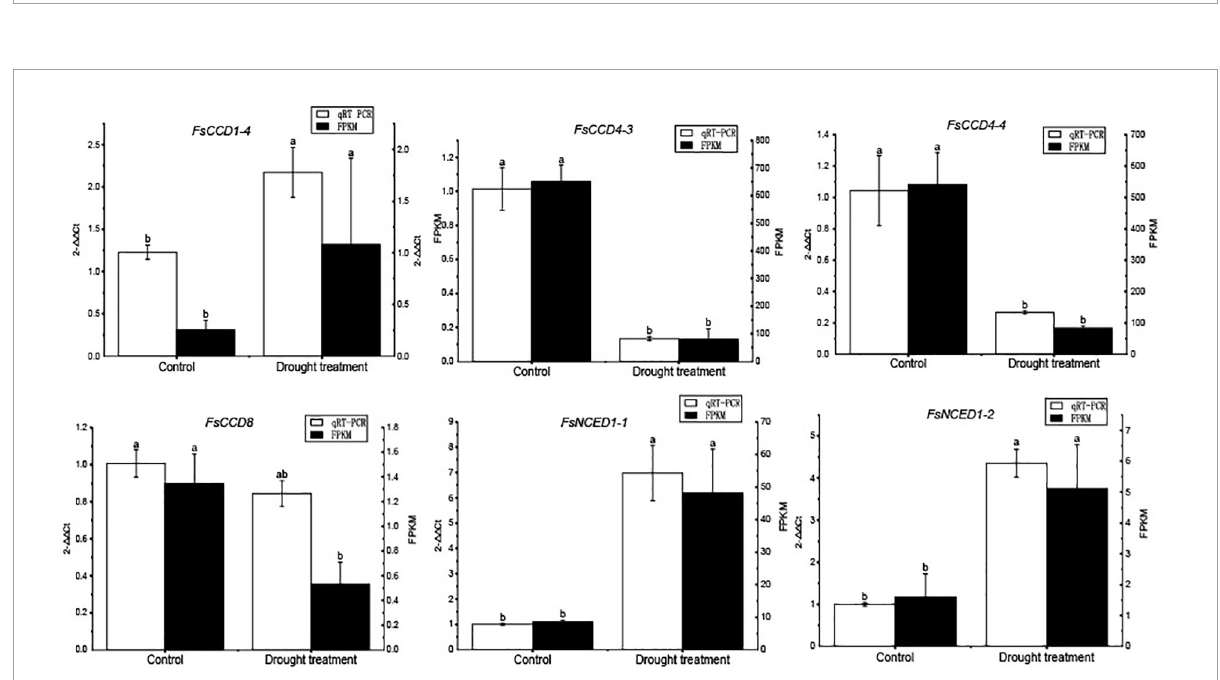
FIGURE10 qRT-PCR verification of the CCD genes of Forsythia suspensa under drought stress. Comparison of q RT-PCR (white bar) with RNA-seq data (black bar). The relative changes were calculated with 2 − (cid:77)(cid:77) Ct . The relative qRT-PCR expression level is shown on the left y -axis. The FPKM from the RNA-Seq data are indicated on the right y -axis. The letters above the bars indicates the significance among different